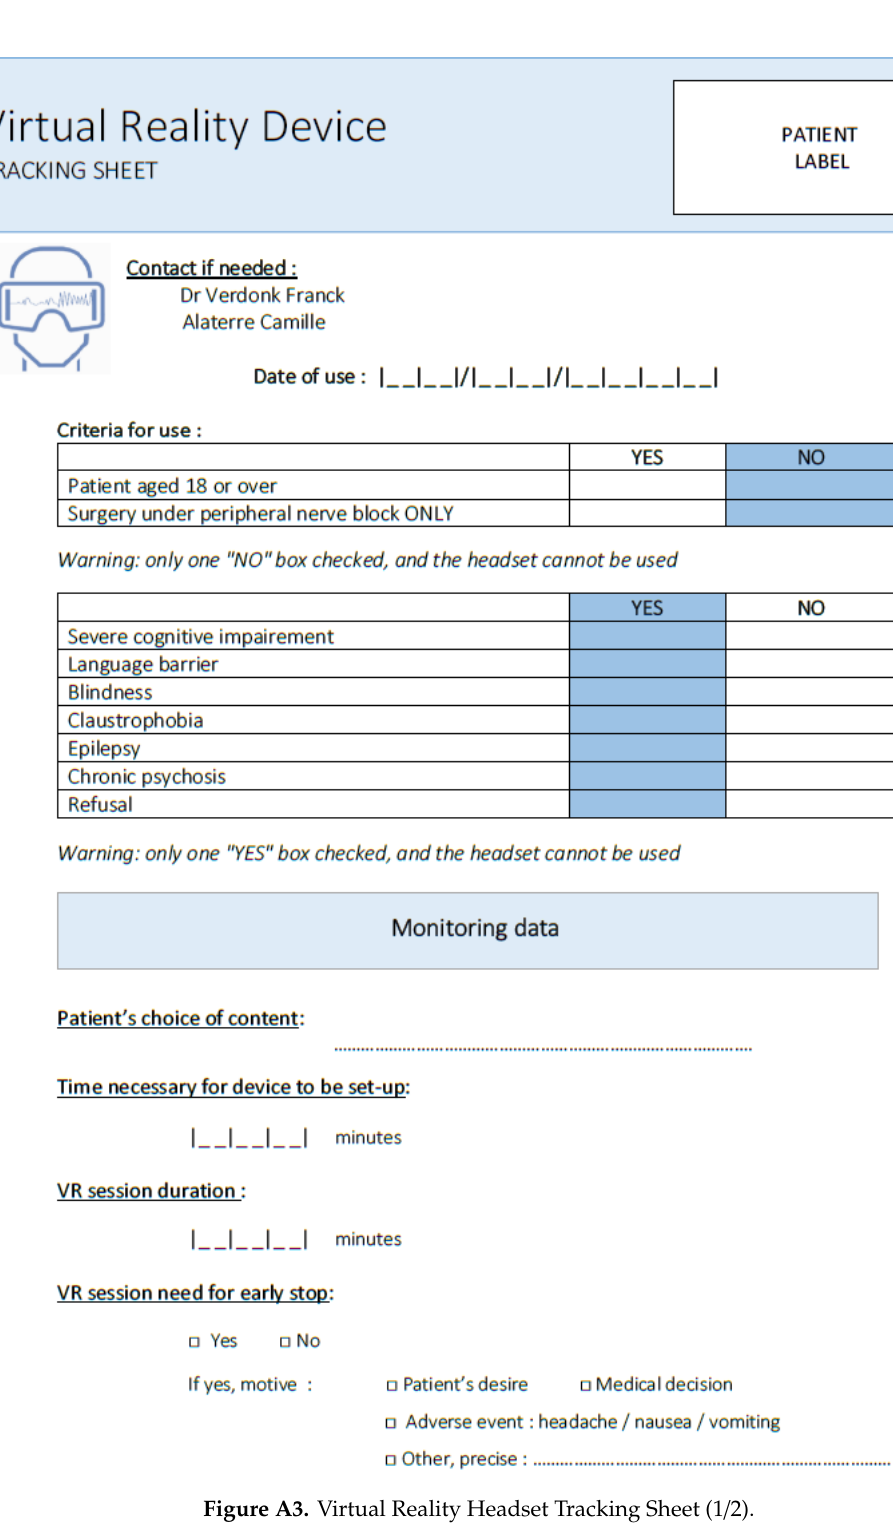
Figure A3. Virtual Reality Headset Tracking Sheet (1/2).